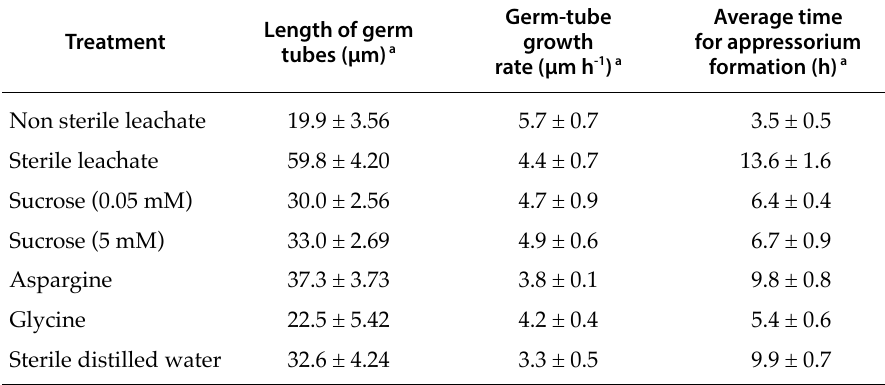
Table 4. Results of Experiments 1c, d and e (Table 1). Mean length (μm) of germ tubes of Colletotricum godetiae conidia forming appressoria after 24 h of incubation, and estimated mean germ tube growth rates (μm h -1 ) and average time for the production of appressoria in sterile and non-sterile olive leachate, solutions containing three different nutrients, and sterile distilled water (control).